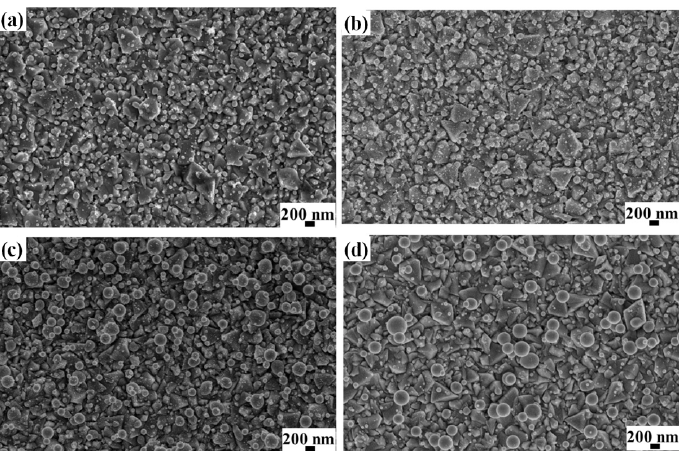
Figure 7. Representative SEM images, acquired near the laser spot center (i.e., region 3), of the nanoparticles formed by irradiating the AuPd film with thickness 4.3 nm ( a ), 7.5 nm ( b ), 29.2 nm ( c ), and 48.6 nm ( d ) deposited on the untreated FTO substrate (substrate A).